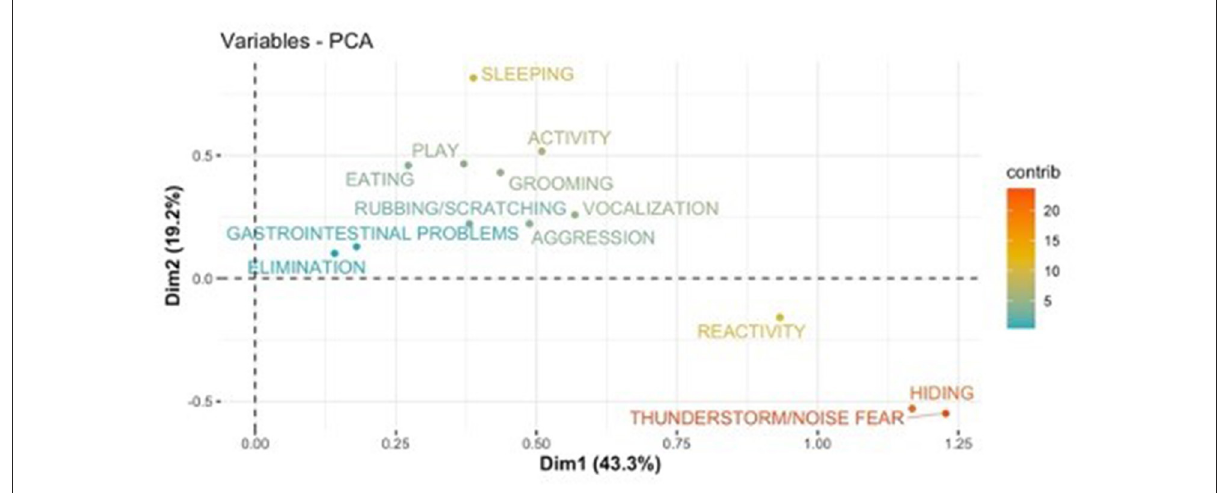
FIGURE8 Loadings plot of the behavioral variables of cats on the first (PC 1) and second (PC 2) principal components with the increase of thunderstorms. The contribution of the variables is colored depending on their